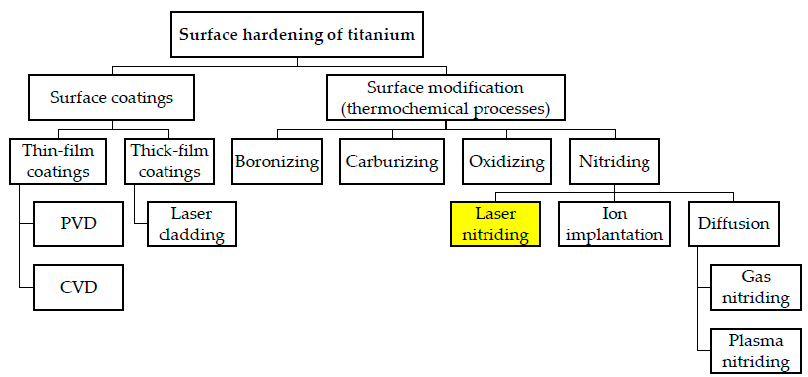
Figure 2. An overview of surface hardening methods for titanium and its alloys.